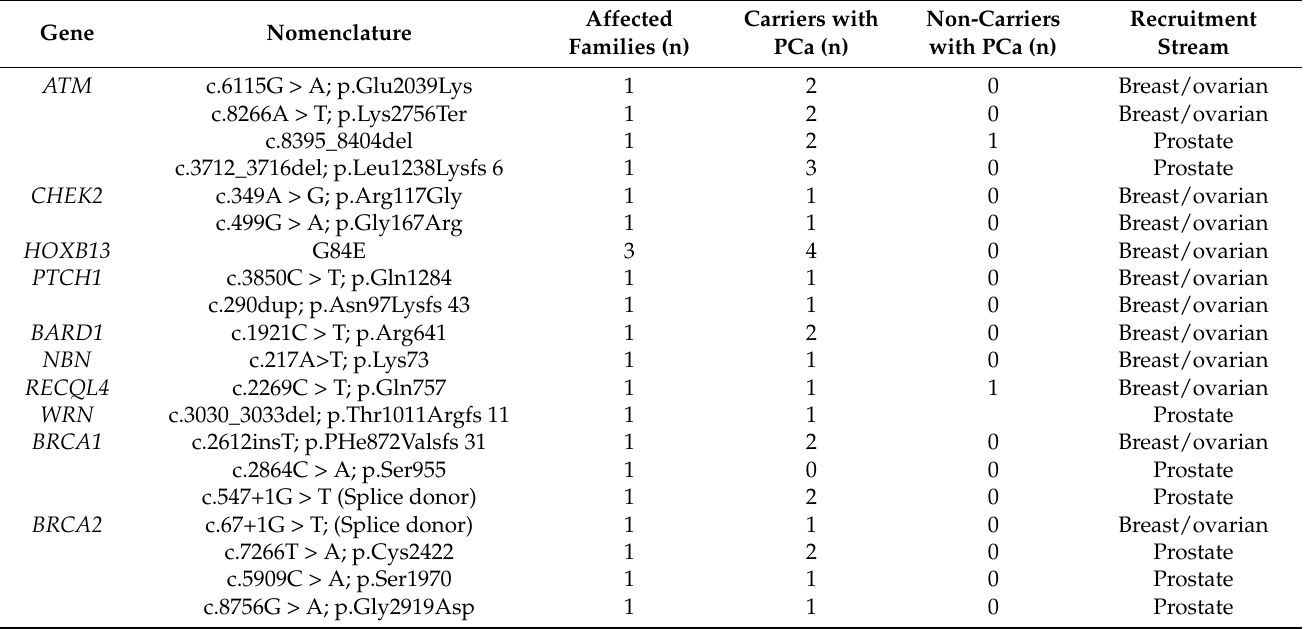
Table 1. Gene nomenclature, affected families, carriers and non-carriers with prostate cancer (PCa) within each family and kConFab recruitment